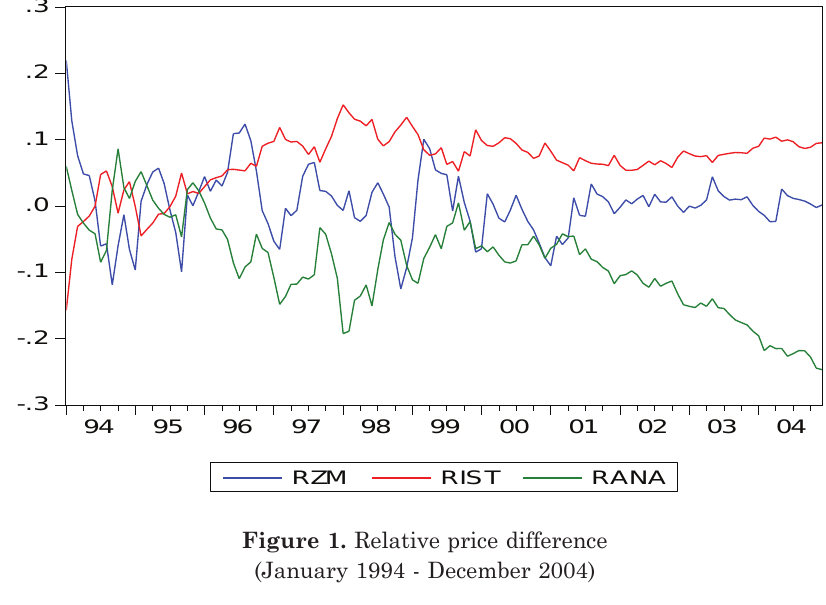
Figure 1. relative price